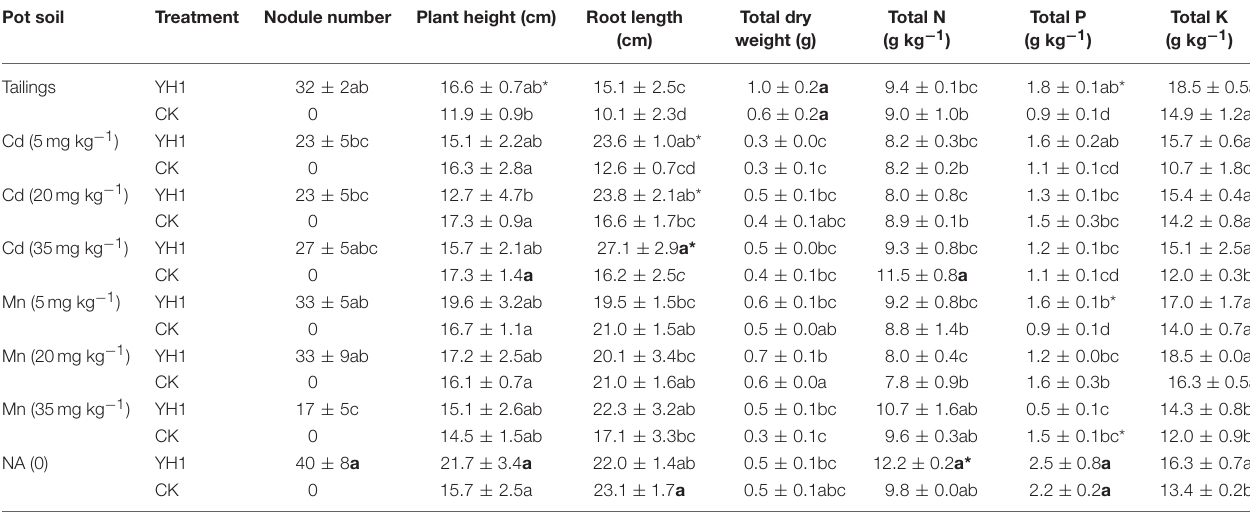
TABLE 2 | Symbiotic nitrogen-fixing and PGP effects of strain YH1 on L. leucocephala after 6 months growth in V-Ti mine tailings and vermiculite supplemented with different concentrations of Cd or Mn. Pot soil Treatment Nodule number Plant height